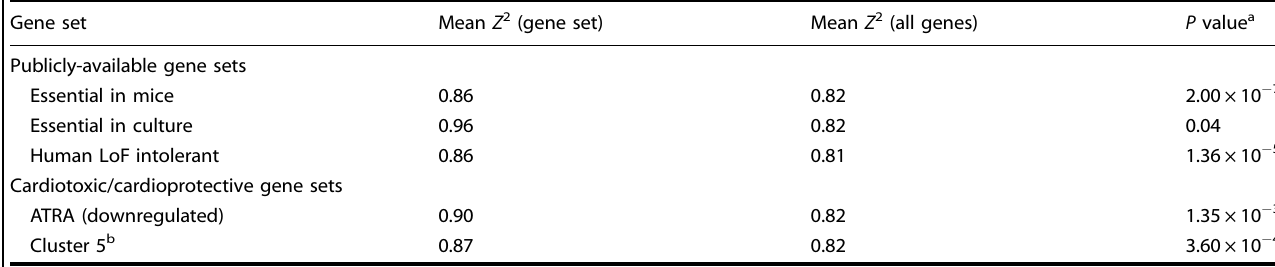
Table 3. Signi fi cantly enriched gene sets across all tissues in the TWAS of ACT. Gene